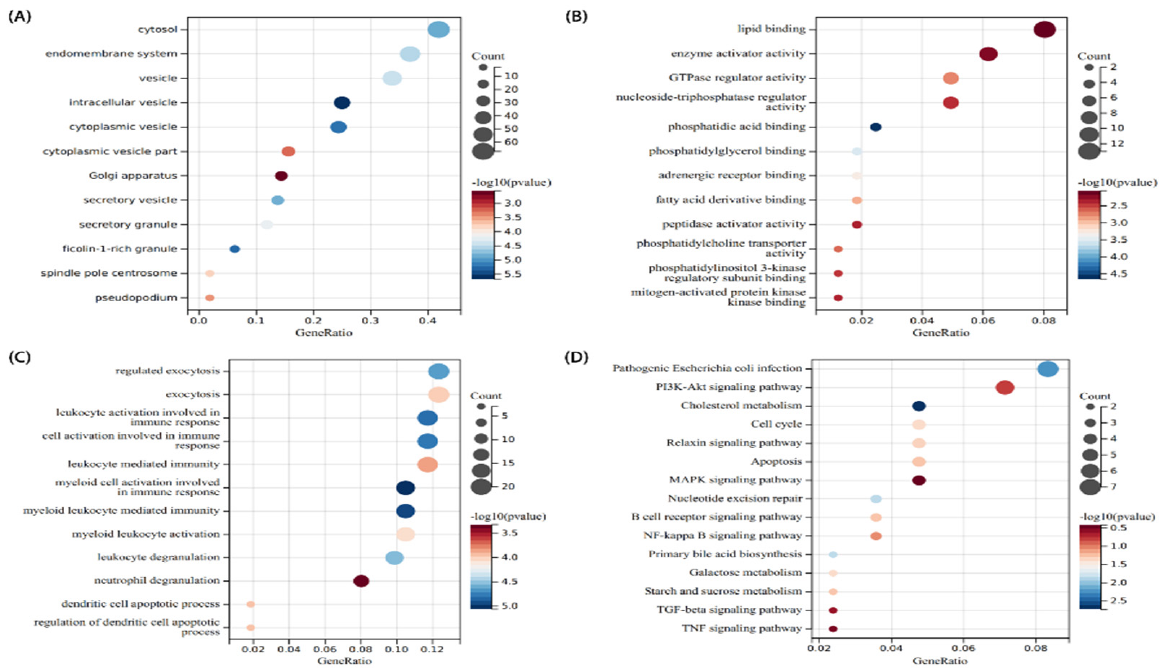
Figure 3. Functional annotation of communal DEGs. ( A ) The cellular component analysis results. ( B ) The molecular function analysis. ( C ) The biological process analysis results. ( D ) The KEGG analysis results. p -value < 0.05 was considered significant.